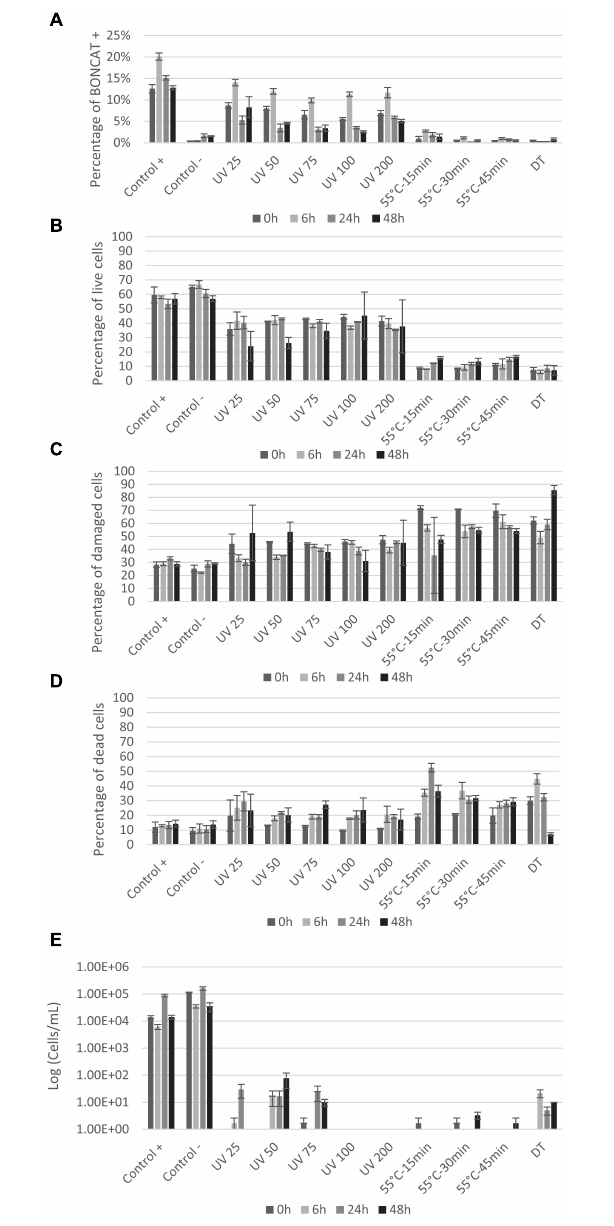
FIGURE 5 | Seawater vitality analysis after treatment: (A) Histogram presenting protein synthesis activity of seawater bacterial communities after UV and heat treatments; (B–D) percentage of live, damaged, and dead cells by LIVE/DEAD R (cid:13) BacLight TM staining. FCM analysis was carried out on 500–1,000 cells at 0, 6, 24, and 48 h after treatments; (E) plate counts from seawater communities at 0, 6, 24, and 48 h after treatments. X-axis shows the different treatments and controls and y-axis represents CFU counts in log